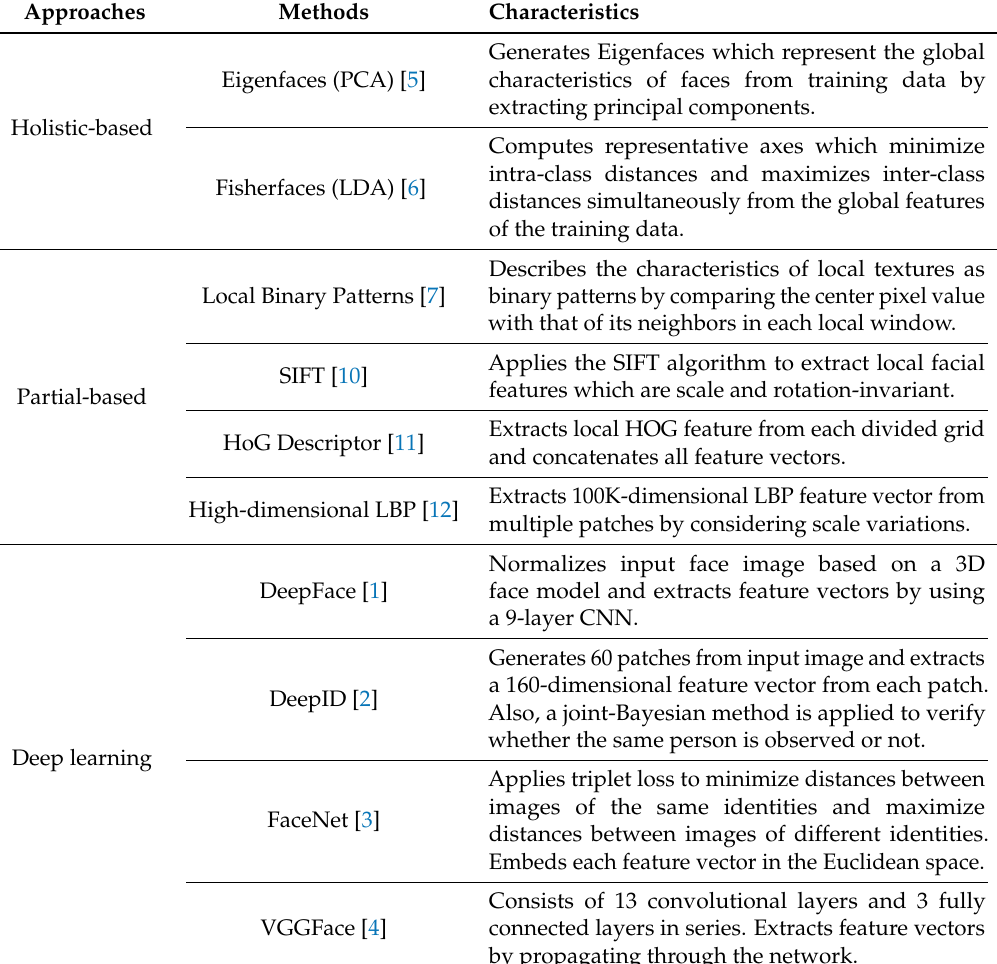
Table 1. A summary of past and current face recognition